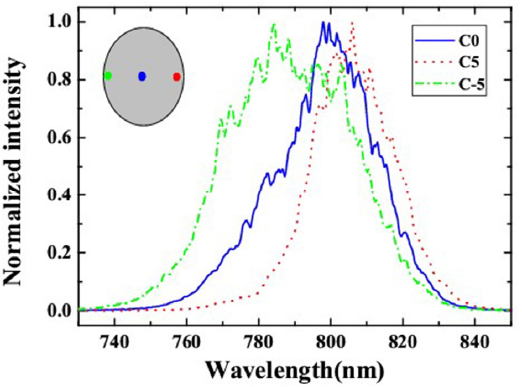
Figure 11. SD spectra measured at three different positions on the beam, C0, C5, and C-5, shown in the inset. C0 is the center of the beam and C5 and C-5 are about 5 mm from C0, with C-5 closer to the incident beams [55].